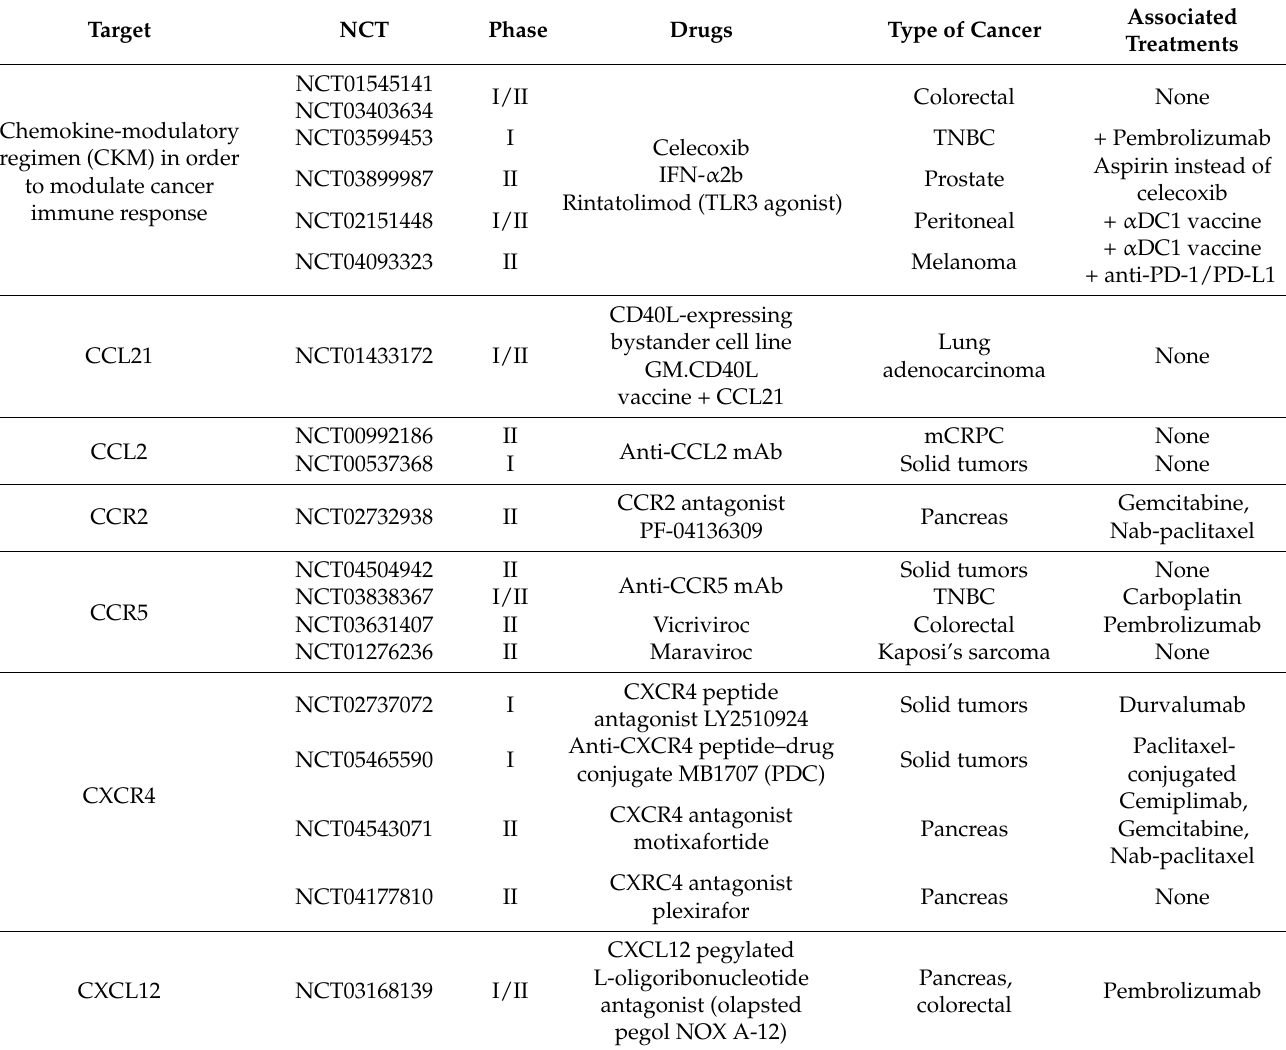
Table 2. Early phase trials focusing on chemokine modulation to treat